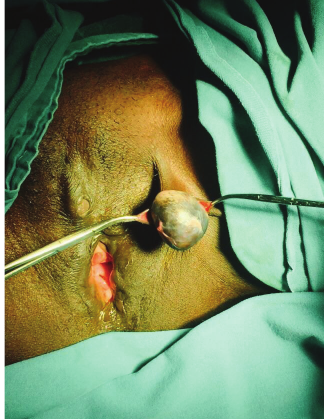
Figure 1: Preoperative inspection of left vulvar region.